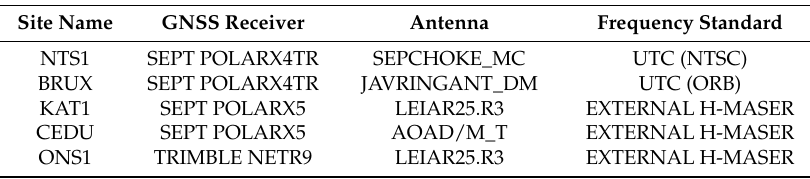
Table 2 . Time links formed and their geodetic distances. Time Link Name